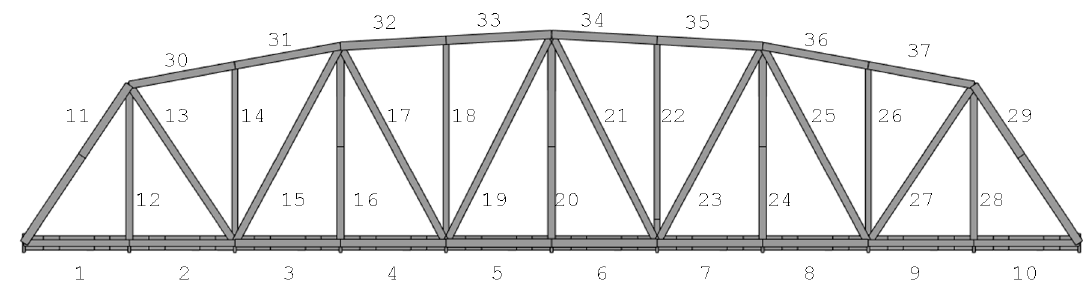
Figure 3. Locations of 10 members with the maximum stresses. Table 1. 10 members with the maximum stresses.